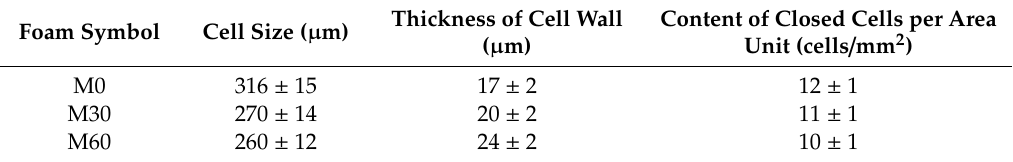
Table 3. Results of SEM micrographs analysis.